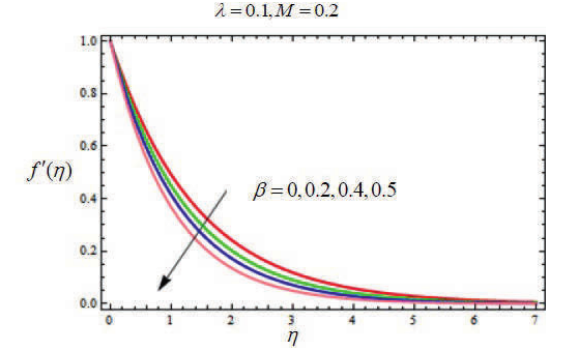
Fig. 7: Variation of velocity f (cid:3) ( η ) with η for several values of Deborah number λ